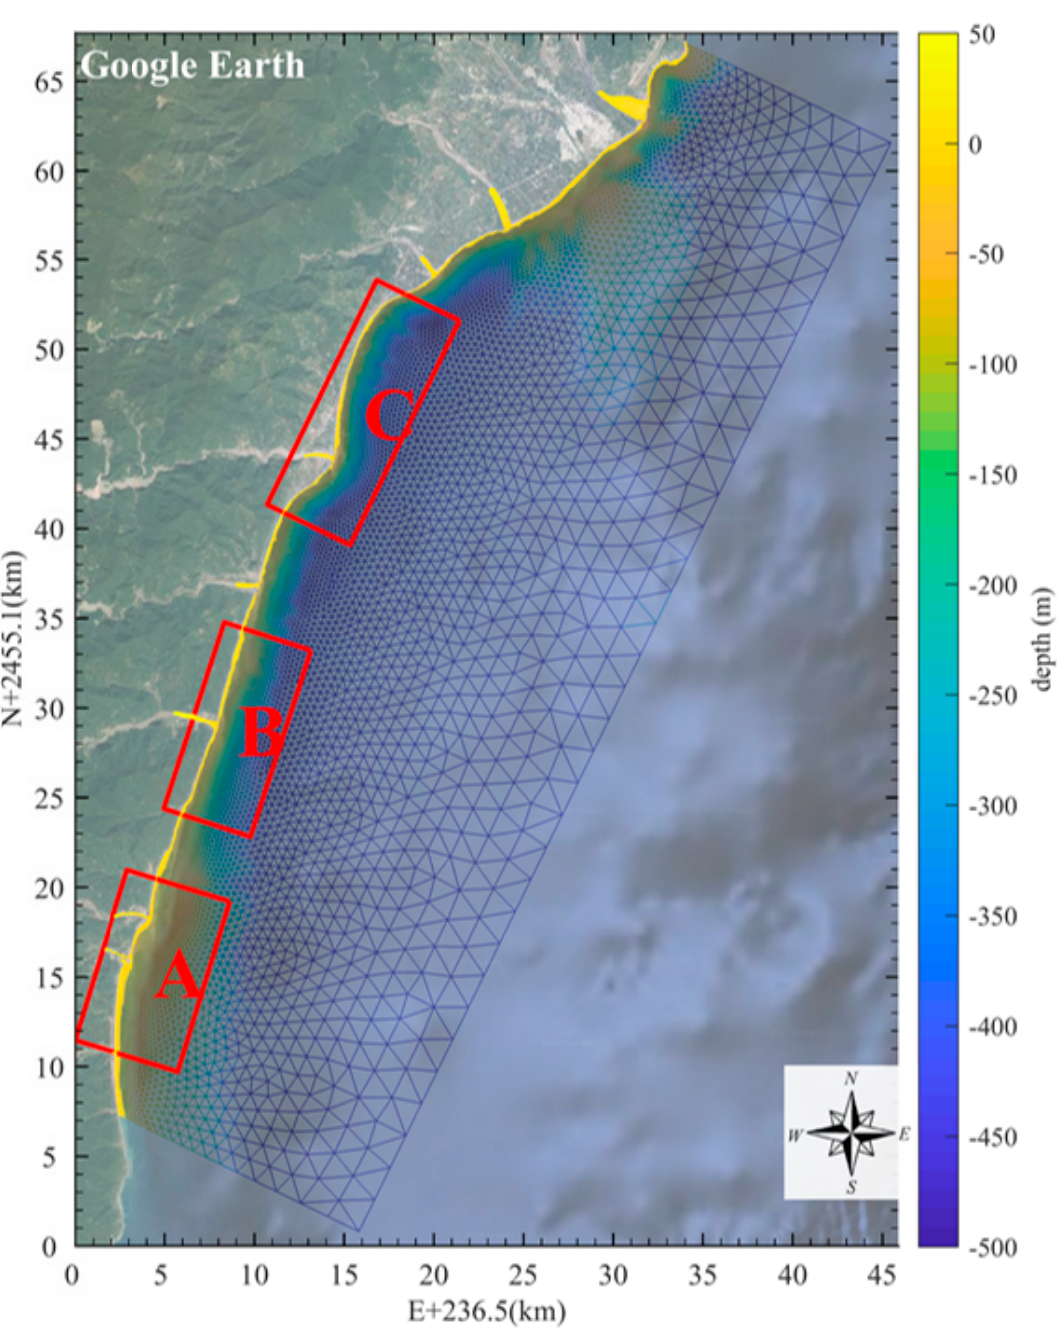
Figure 10. Unstructured grid for Medium-field